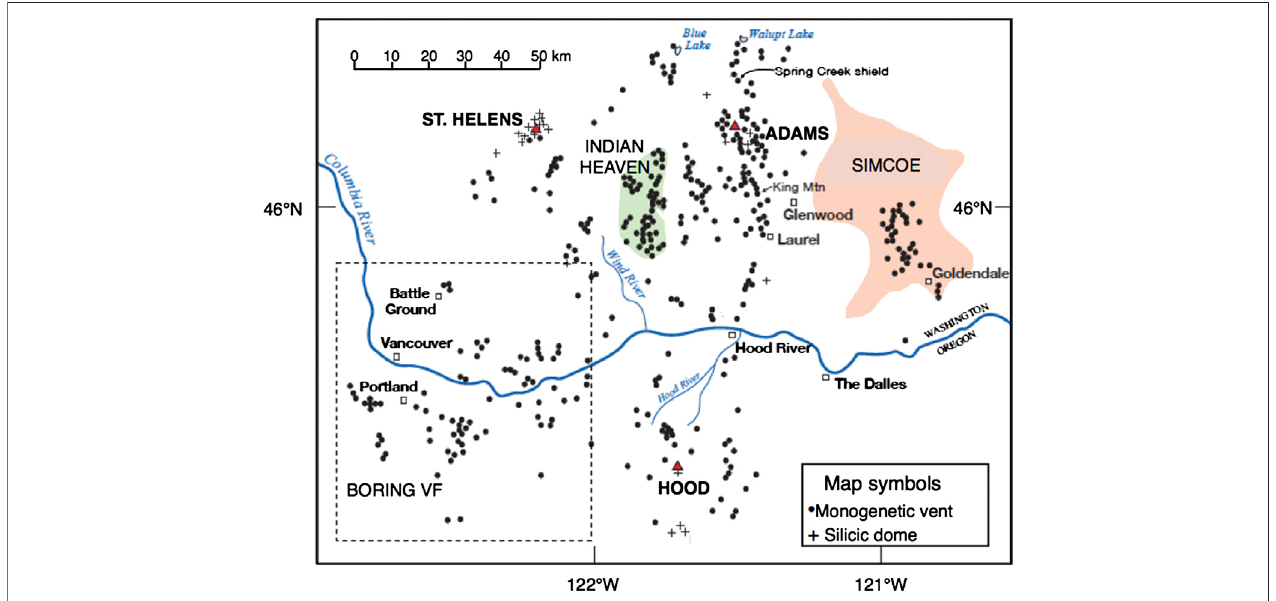
FIGURE 4 | Map of volcanic fi elds, monogenetic vents, and stratovolcano complexes (Mt. St. Helens, Adams, and Hood) in the Cascades Columbia Transect (CCT), near latitude 46 ° N (after Hildreth, 2007). Indian Heaven (green shading) and Simcoe (red shading) are coherent volcanic fi elds of dominantly ma fi c lavas. Dashed rectangle is location of Boring Volcanic Field, shown in more detail in Figure 8